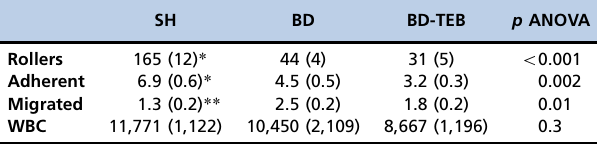
Figure 3 - Expression of intercellular adhesion molecule (ICAM)-1 on mesenteric endothelial cells (p ANOVA o 0.001) and the serum levels of corticosterone (p ANOVA=0.01) in sham-operated rats (SH), brain-dead non-treated rats (BD), and brain-dead rats under thoracic epidural blockade (BD-TEB) 180 min after the surgical procedures. The data are presented as the means ± SEM. * p o 0.05 vs. the other groups. Table 2 - The results of the evaluation of the serum Table 1 - The results of the evaluation of the rat cytokine levels via enzyme-linked immunosorbent assays. mesenteric microcirculation via intravital microscopy.